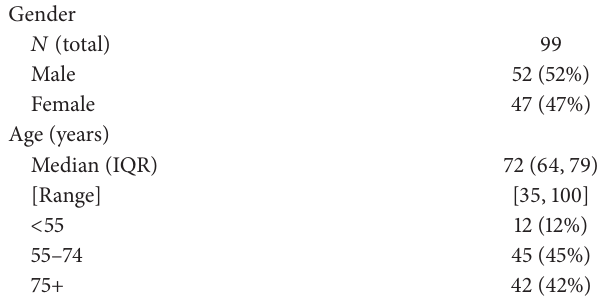
Table 2: Demographics of patients presenting with